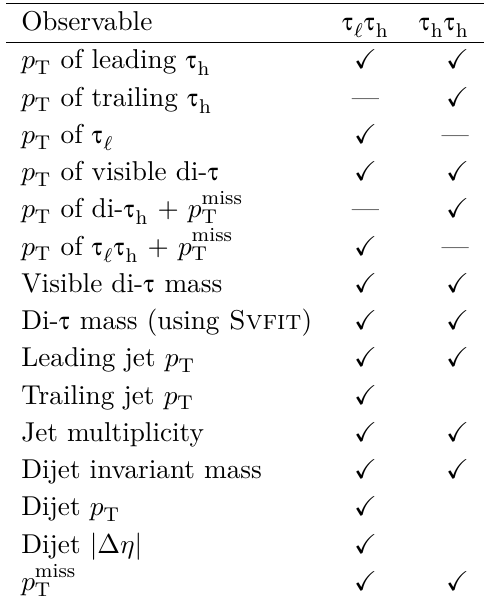
and t channels. The Svfit ‘ t h h t h